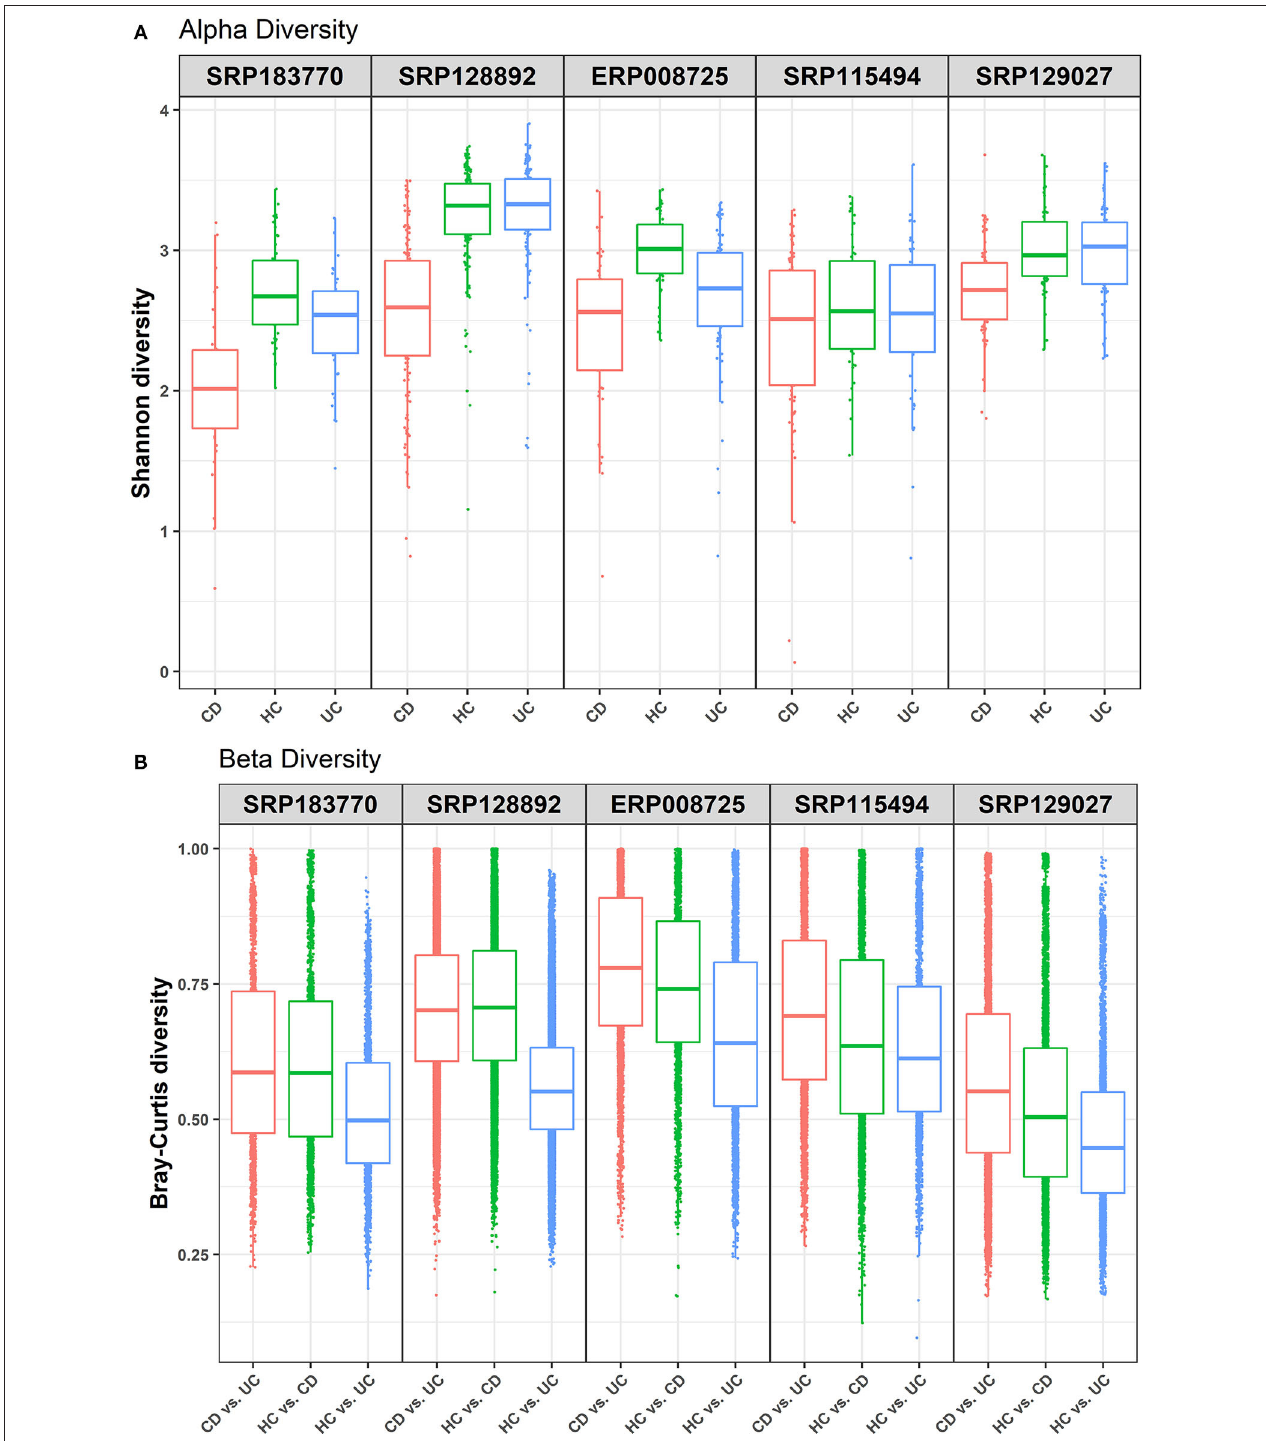
FIGURE 1 | Alpha and beta diversity comparisons among HC, CD and UC cohorts. Analyses were performed on species-level taxa. (A) Boxplot showing Shannon diversity of each group. Each dot represents a sample and the lines in the boxes correspond to the median of samples; (B) Bray–Curtis distances between the comparison pair. Dots represent the distance between the samples in each comparison group and the lines in the boxes correspond to the median.